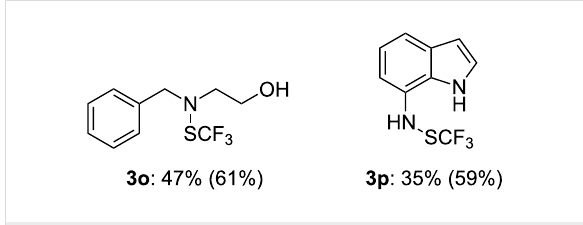
Figure 2: Reaction of 1a with bis-nucleophiles. (Isolated yields, in parentheses crude yields determined by 19 F NMR with PhOCF 3 as an internal standard).